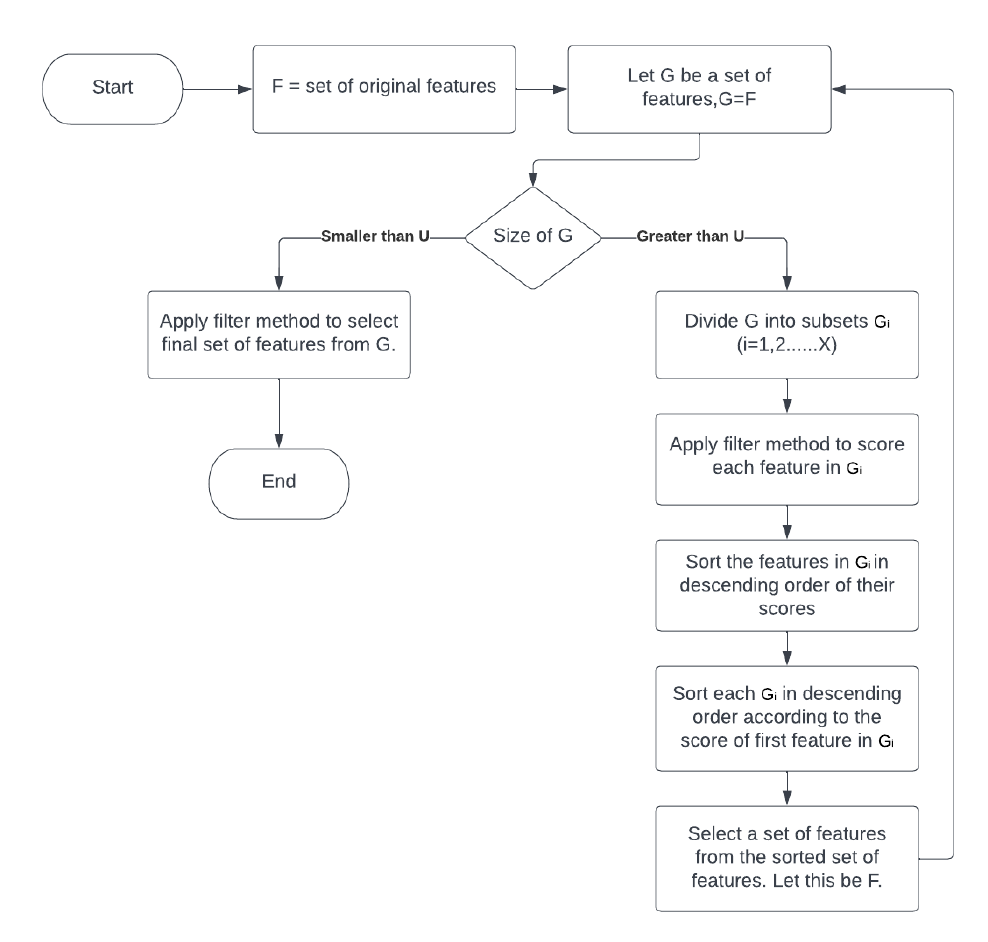
Figure 3. Flowchart of the process. The pseudocode of the proposed approach is explained in Algorithm